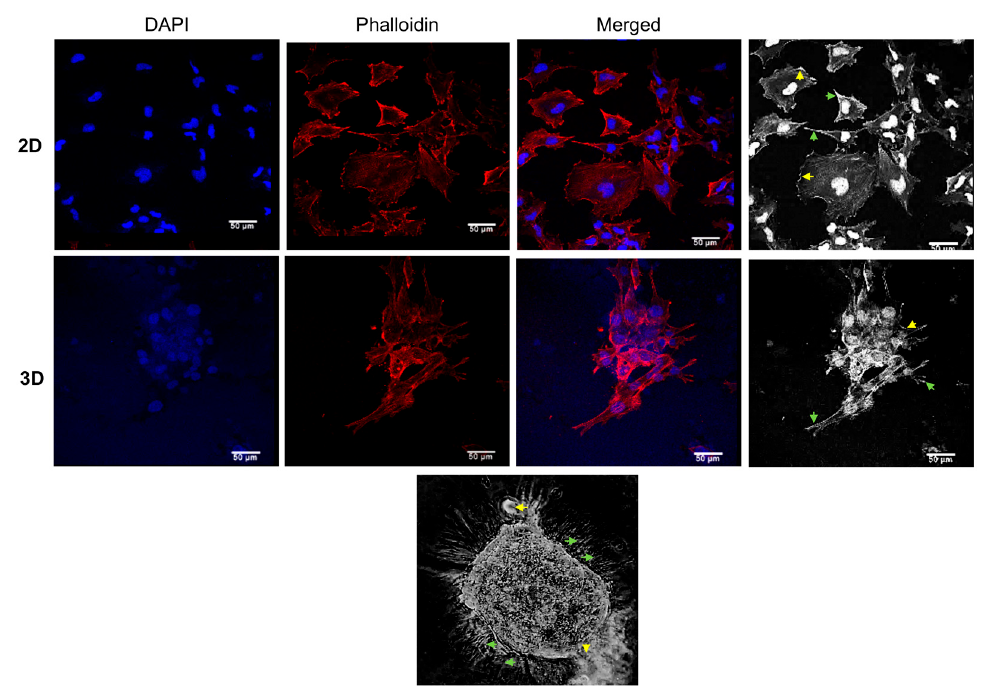
Figure 2. Morphology of Hs578T cells cultured in 2D and 3D cultures. Confocal microscopy images of 2D (top panel) and 3D (middle and bottom panel) cell cultures incubated with phalloidin-rhodamine for staining of F-actin stress fibers (red signal). Nuclei were counterstained with DAPI (blue signal). Lamellipodia-(yellow arrows) and filopodia-like (green arrows) structures. Scale bar = 50 μ m.